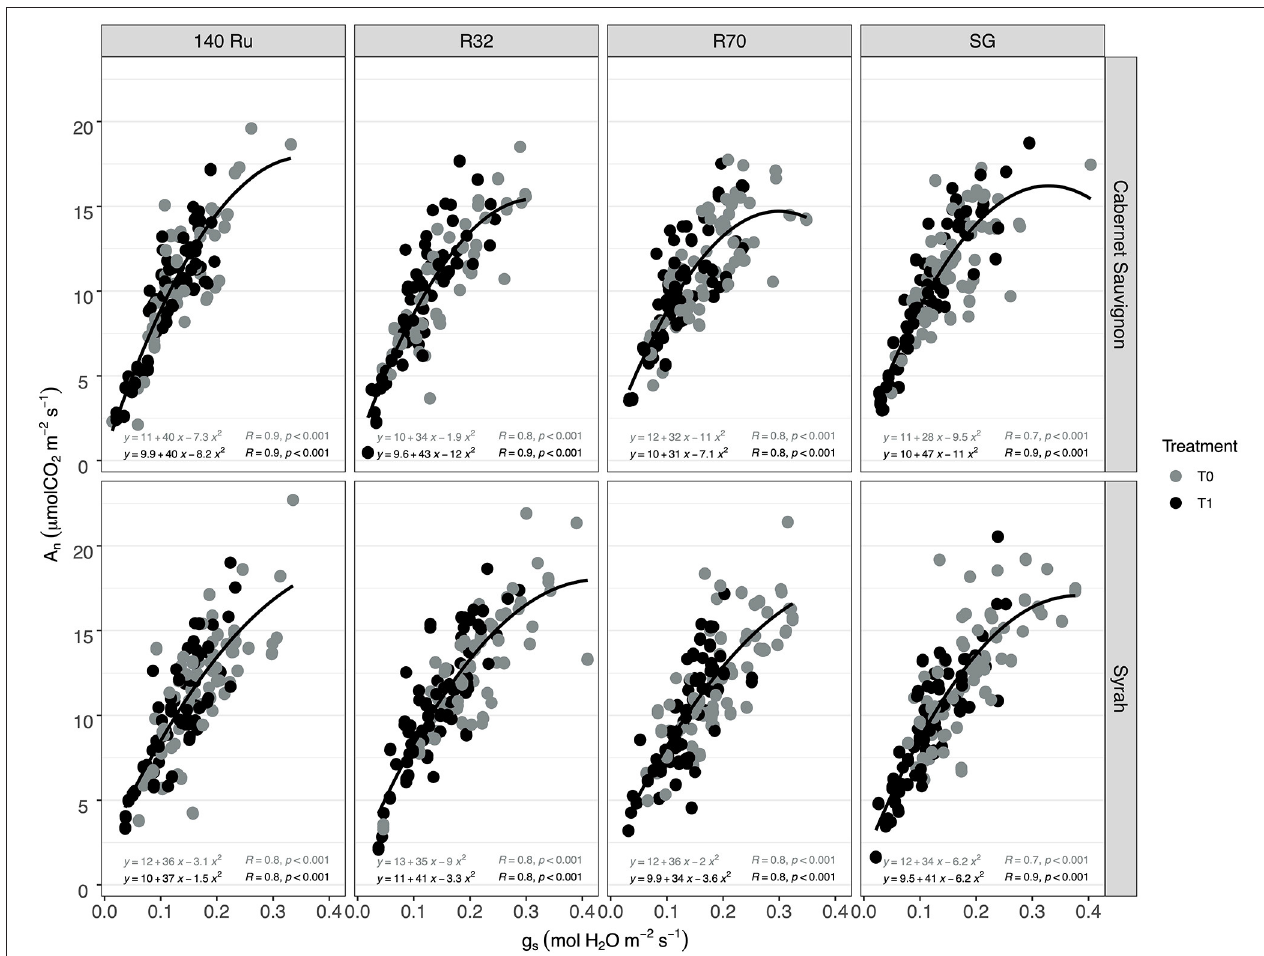
FIGURE 2 | The relationships between photosynthesis (A n ) vs. stomatal conductance (g s ) in two cultivars (Cabernet Sauvignon, CS, and Syrah, Sy) over different rootstocks under two irrigation treatments.